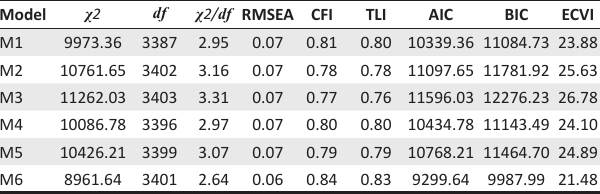
TABLE 3: Summary of goodness-of-fit statistics for the various Ryff Scales of Psychological Well-Being models tested.